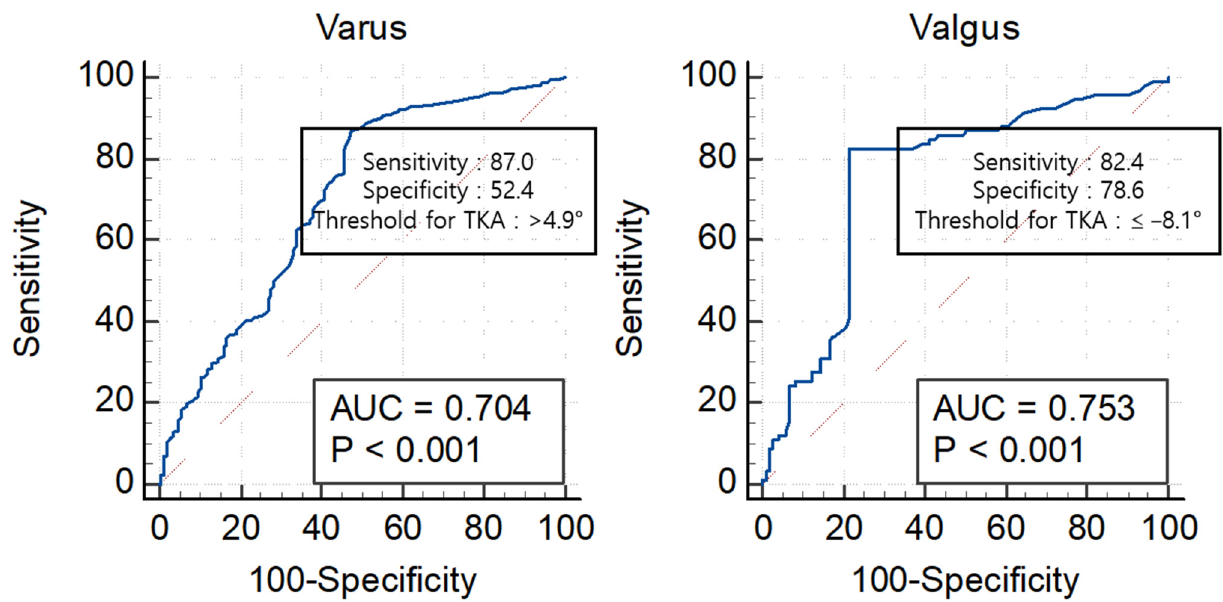
Figure 5. ROC curve for TKA of varus and valgus arthritic knees using the HKA. ROC, receiver operating characteristic; TKA, total knee arthroplasty; AUC, area under the ROC curve; HKA, hip–knee–ankle angle.